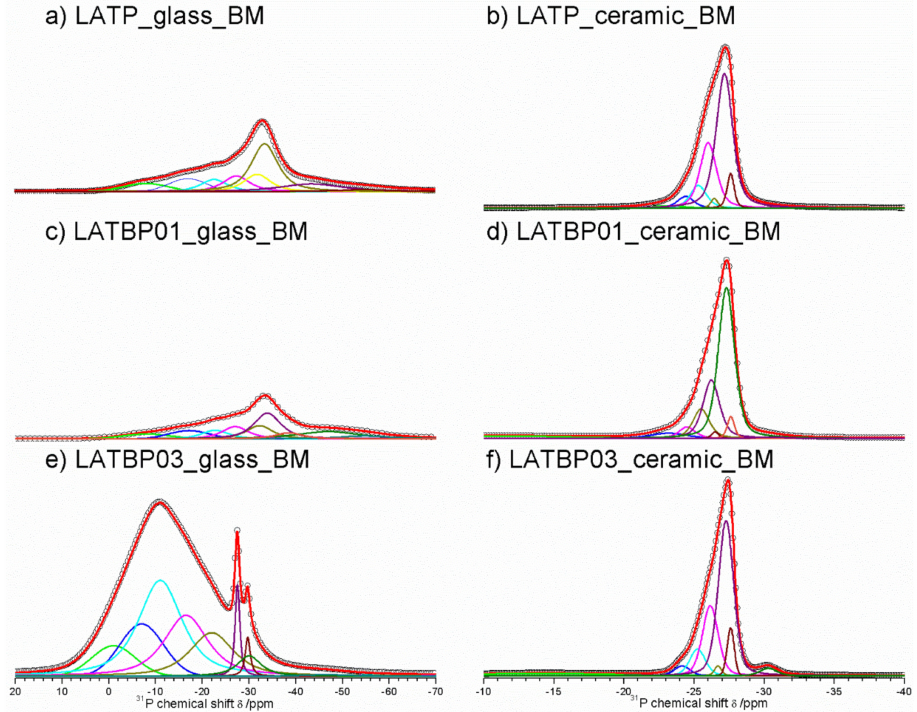
Figure 11. 1D 31 P MAS NMR spectra of the LAT(B)P_BM series. ( a ) LATP_glass_BM ( b